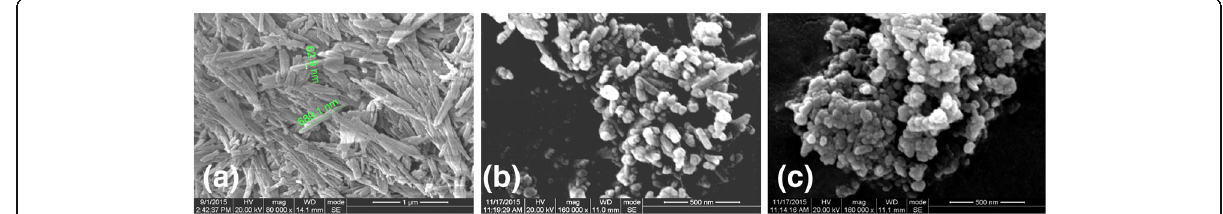
Fig. 2 SEM images of a ATP, b ATP/TiO 2 , and c ATP/TiO 2 /Ag 3 PO 4